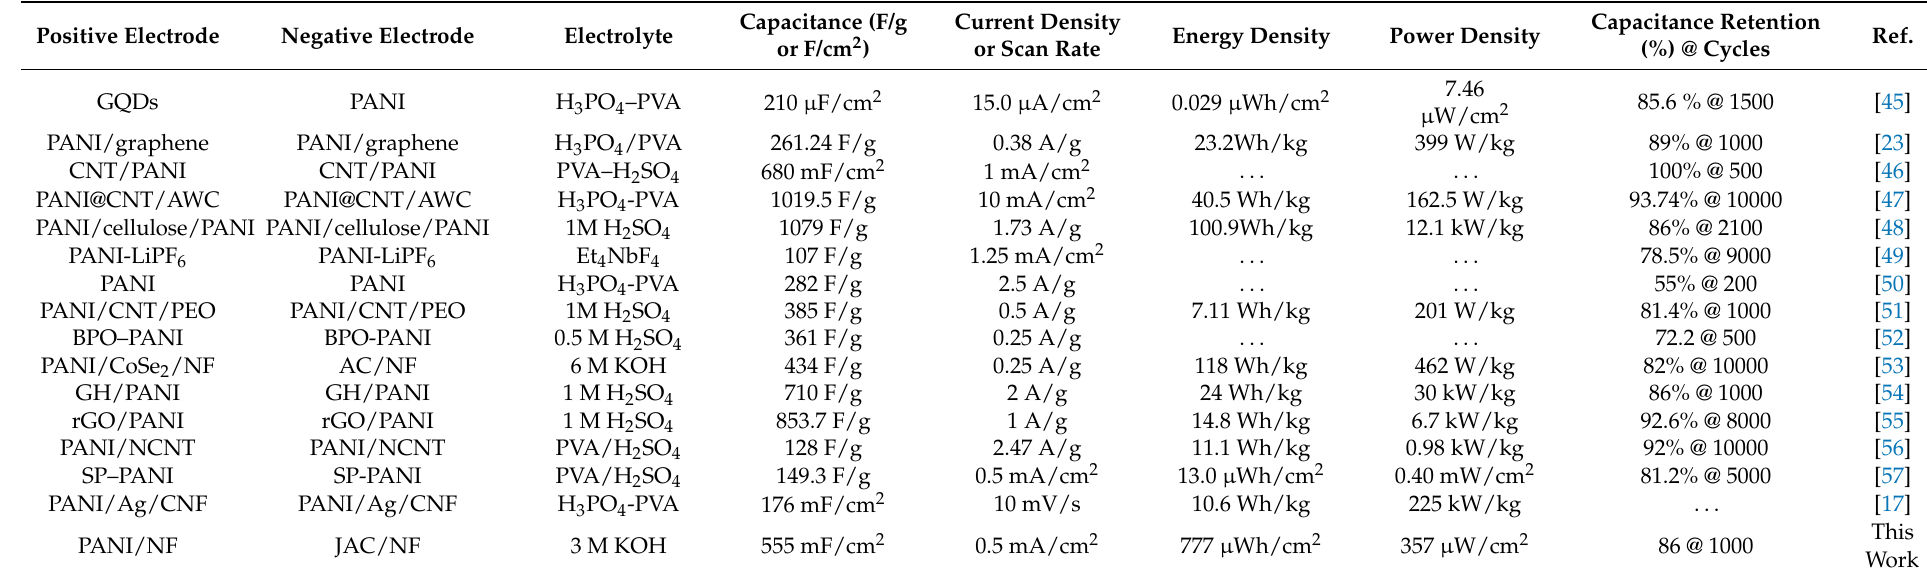
Table 2. Comparison of the fabricated PANI/NF//JAC/NF ASC with the reported PANI-based ASCs in the